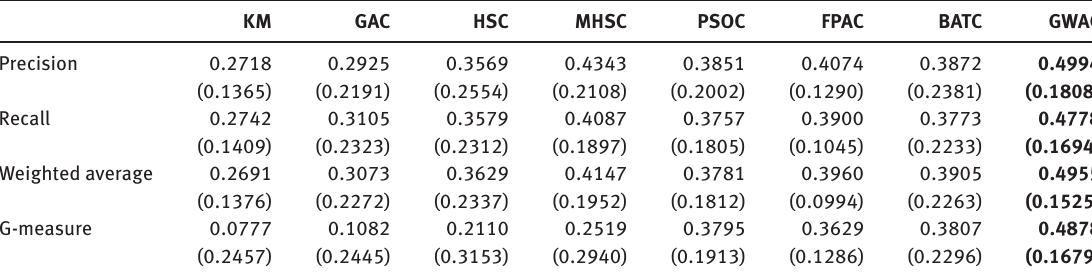
Table 6: Mean (SD) of Cluster Quality Matrices for Wine Data Set.